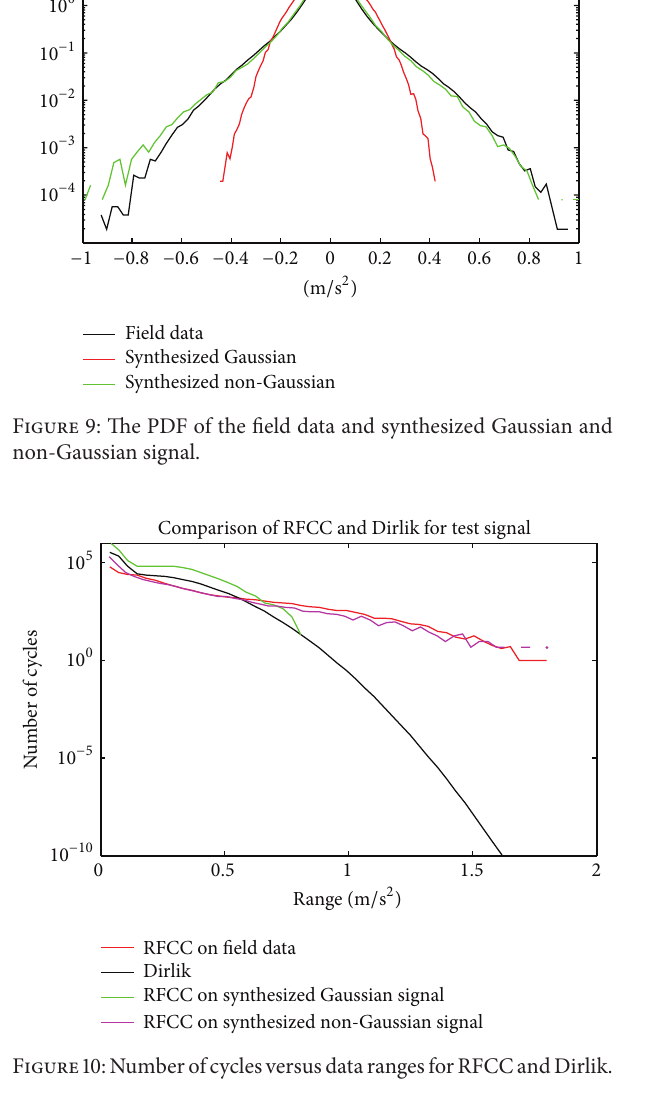
non-Gaussian signals. The middle of this PDF is shaper and the tails are narrower. This indicates that large correlation time may lead to inaccurate